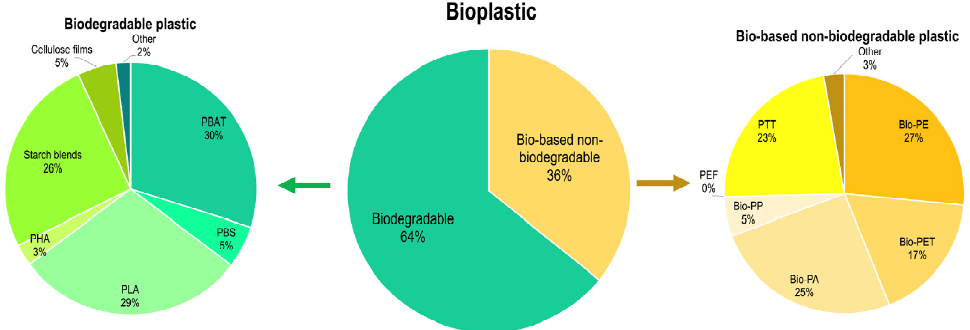
Figure 1. Global production capacities of bioplastics (adapted from European Bioplastics and nova-Institute [22]).